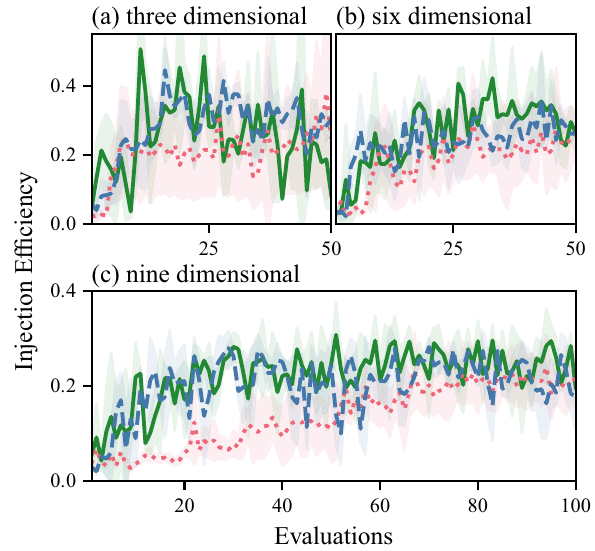
FIG. 6. Experimental optimization result of the injection efficiency using BO with two different acquisition functions and Nelder-Mead algorithm (red, dotted). UCB (green, solid) and EI (blue, dashed) have similar results and are both able to optimize the injection efficiency within a reasonable number of evaluations. For a nine-dimensional problem, NM is clearly slower than